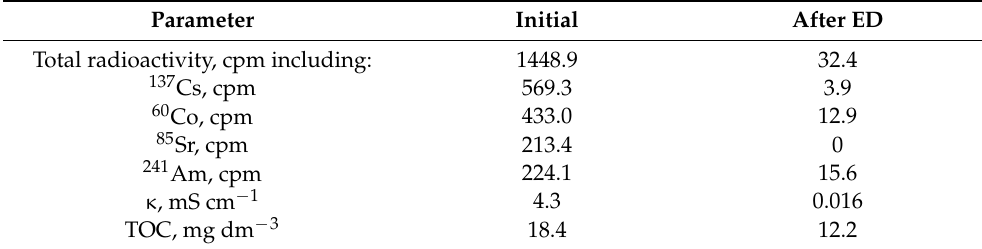
Table 7. The treatment of liquid waste sample using ED.